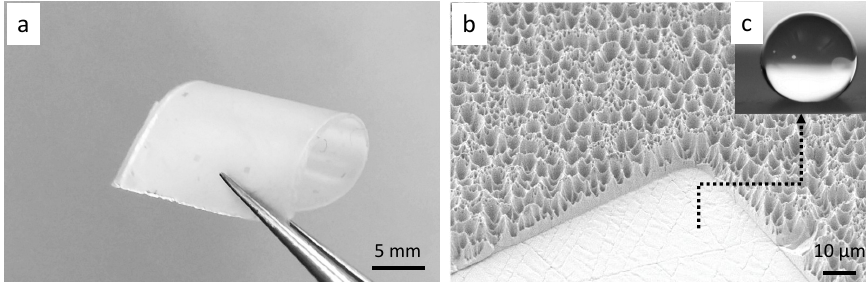
Figure 3. Superhydrophobic PDMS stamp with Pd pads: ( a ) a soft patterned PDMS substrate; ( b ) scanning electron micrograph of a corner of a Pd pad with PDMS substrate; ( c ) a droplet of water is confined inside a Pd pad surrounded by superhydrophobic PDMS